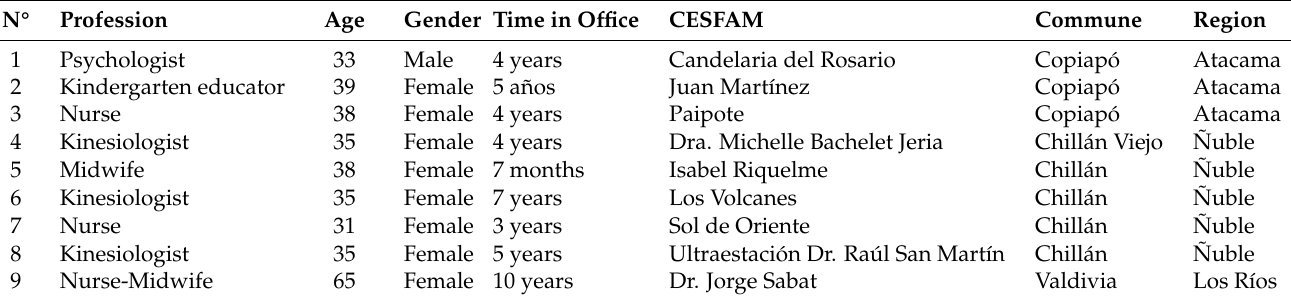
Table 1. Characteristics of Quality